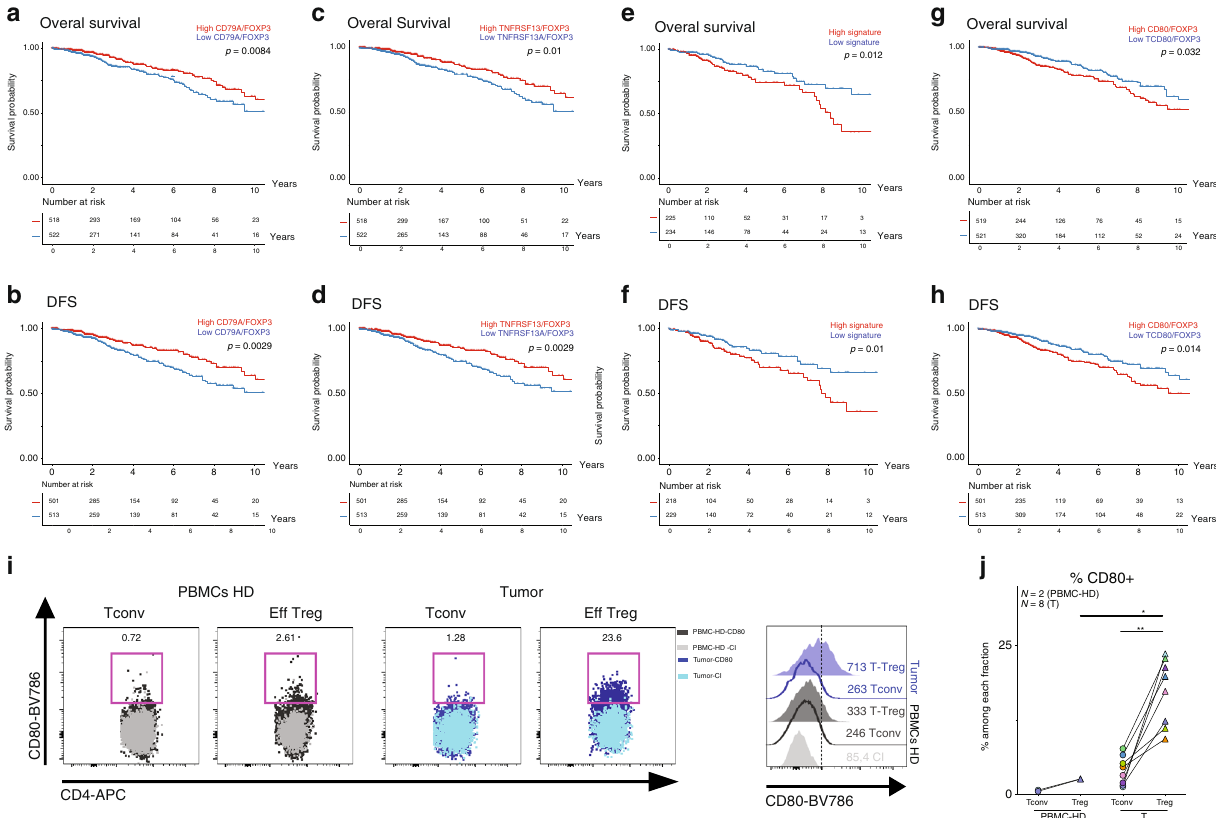
Fig. 7 Clinical outcome of differentially expressed genes normalized to FOXP3 expression. a – h OS (upper panels) and DFS (lower panels) of patients with breast cancer strati fi ed by “ high ” or “ low ” median intensity of the expression level of CD79, TNFRSF13B, “ CD80 , CCR8, and HAVCR2 signature ” and CD80 normalized to FOXP3 expression, in TCGA breast cancer data set. i Representative fl ow cytometric analysis of CD80 expression on Tconv and Treg cells from HD PMBCs (left panels) or tumor (right panels) and representative histogram of CD80 MFI levels in the different subpopulations. j Frequency of CD80 + CD4 + Tconvs or Tregs in HD PBMCs ( N = 2) or tumors CD45 + cells ( N = 8). PBMC-Treg vs tumor-Treg p = 0.044. Mann – Whitney test. Tumor- Tconv vs tumor-Treg p = 0.0078. Wilcoxon matched-pairs signed rank test, * p < 0.05, ** p <